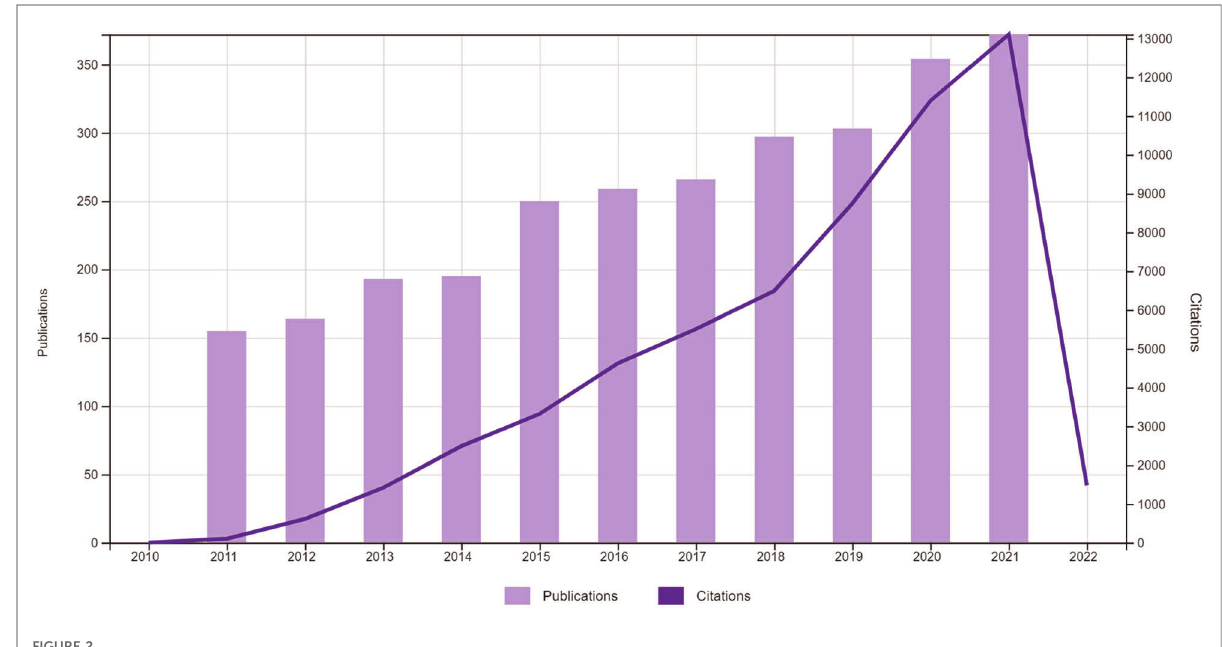
FIGURE 2 Paper publication and citation numbers in the last ten years (2011 –